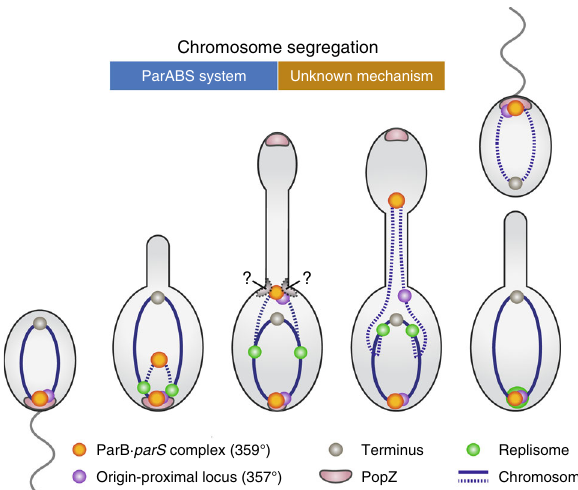
Fig. 10 Model of the two-step chromosome segregation process in H. neptunium . In swarmer cells, the ParB· parS complex interacts with the scaffolding protein PopZ, thus anchoring the ori region at the fl agellated pole. At the onset of S-phase, the replisome assembles at ori and the two replication forks start to move independently along the two arms of the chromosome. Soon after the initiation of replication, the two sister ori regions are segregated within the mother cell body, driven by the ParAB S chromosome partitioning system. One of the two ori regions is immobilized at the stalk base, potentially through interaction of ParB with a thus-far unknown landmark protein. Once the replication forks have reached the last third of the chromosome, the second segregation step starts and the stalled ori region is translocated through the stalk to the bud compartment. After attachment of the ParB· parS complex to the fl agellated bud pole and translocation of the remaining bulk of chromosomal DNA, the cell divides. The resulting stalked cell immediately starts the next replication cycle, whereas the swarmer cell fi rst has to differentiate into a stalked cell